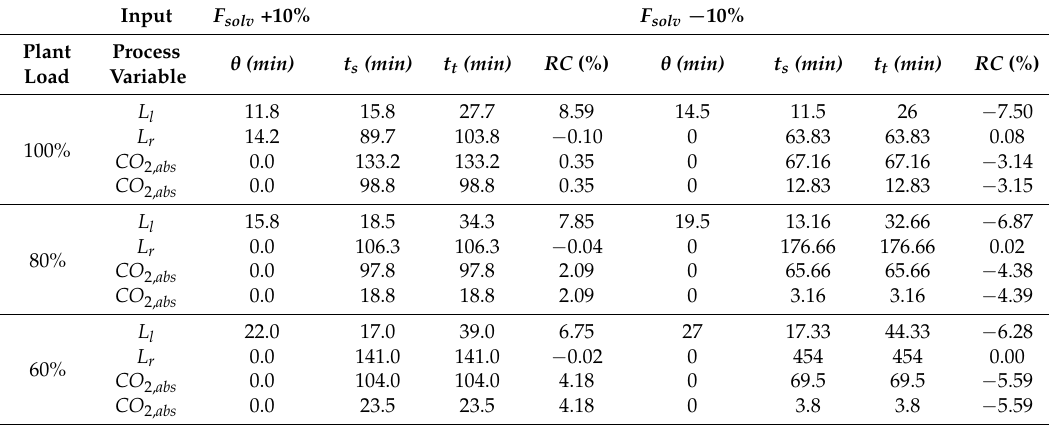
Table A2. Open-loop response to ± 10% step-changes in solvent mass flow rate for three different operating points of the pilot plant. Responses in CO 2 lean loading L l , CO 2 rich loading L r , CO 2 absorbed, and CO 2